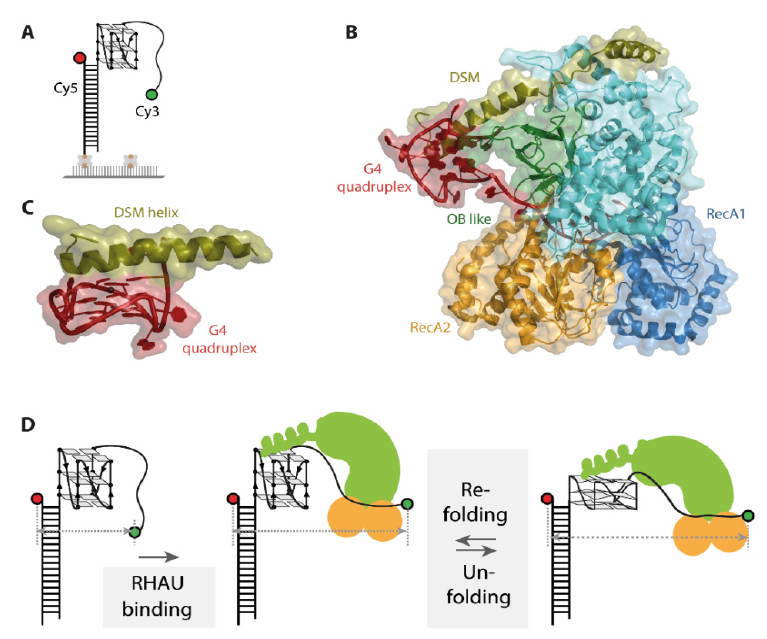
Figure 4. ( A ) Schematic representation of one G-quadruplex (G4) single molecule Förster resonance energy transfer (smFRET) construct used in the described studies. ( B ) Co-crystal structure (pdb 5VHE) of RHAU in complex with a c-Myc G-quadruplex, color-coded for di ff erent important